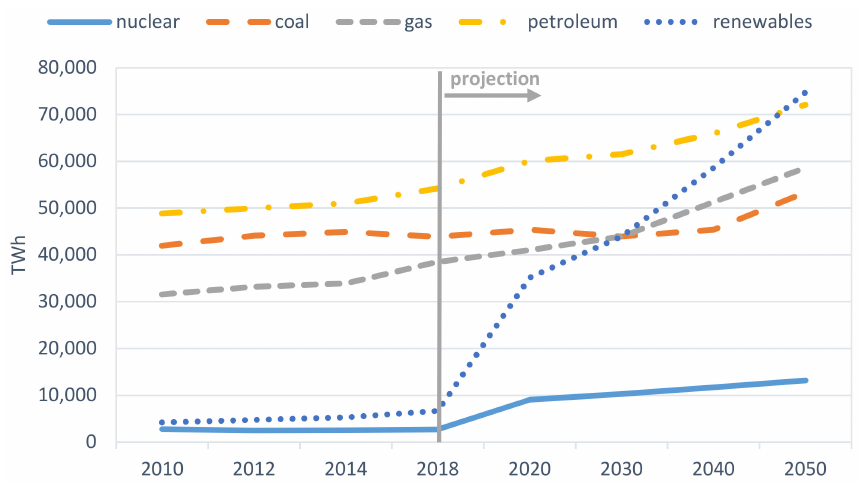
Figure 1. Global primary energy consumption by energy source (below 2018-historical data, above 2018- projections) [4].